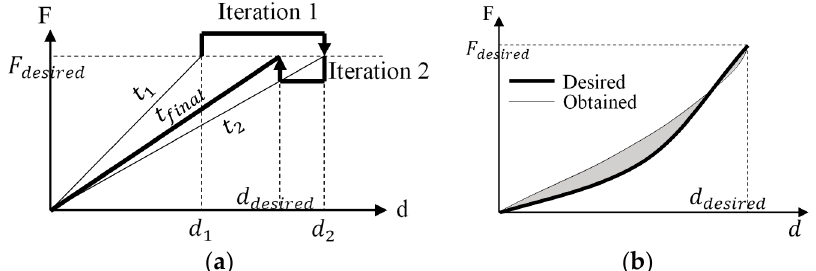
Figure 2. ( a ) Process of thickness adaptation through thickness adaptation on the force-displacement curve. ( b ) Desired and obtained force-displacement curve. The hatched area shows